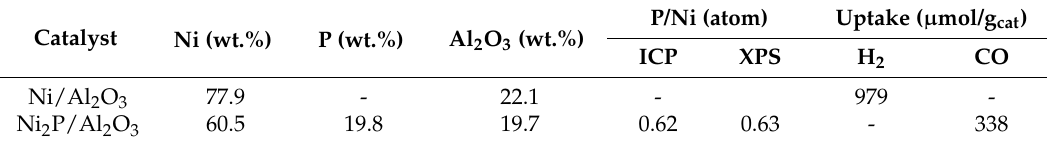
Table 2. Chemical composition for the Ni/Al 2 O 3 and Ni 2 P/Al 2 O 3 catalyst.